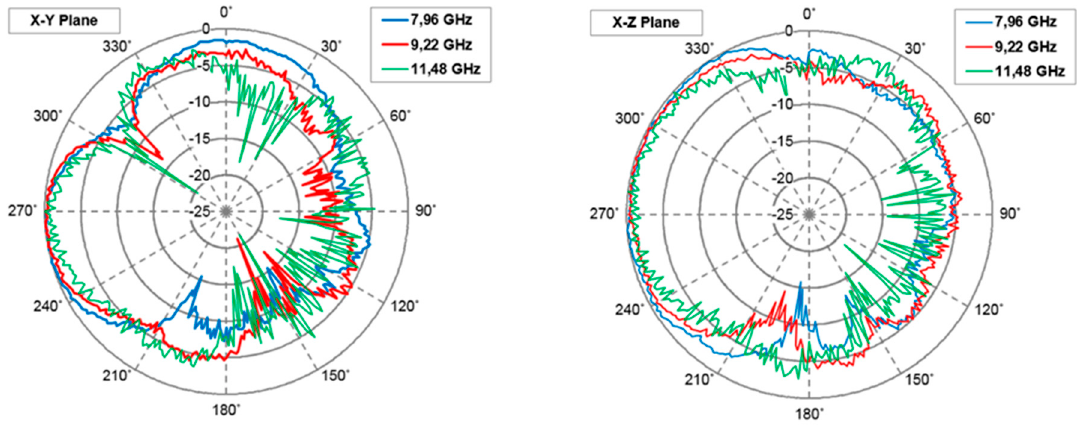
Figure 8. Results of measured radiation patterns of the antenna.